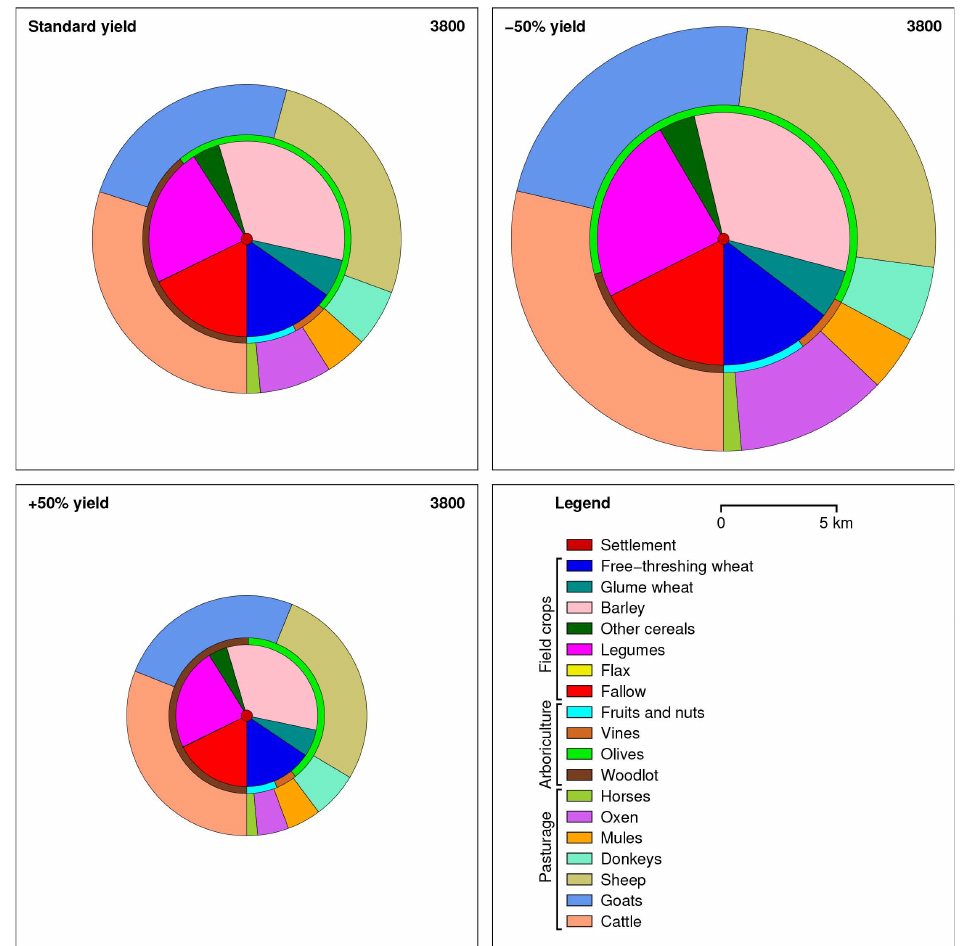
Figure 4. Altering yield assumptions (see Table S1, with references in Table S2, for yields used in this study). The raw numerical results and win-loss diagram are presented in Table